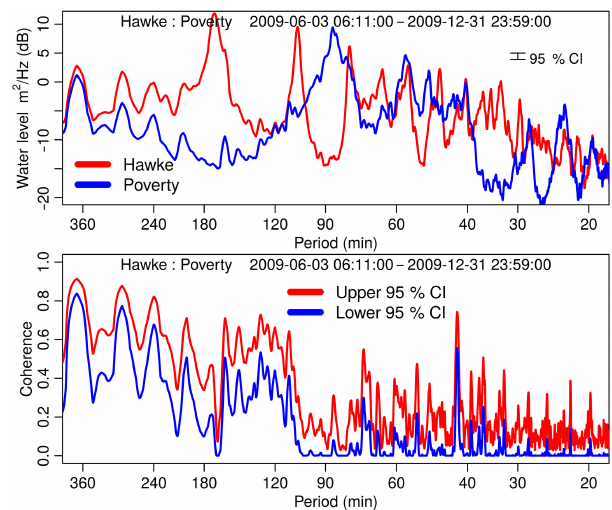
Figure 4. Power spectral density (top) of concurrent water levels at Napier in Hawke Bay, and Gisborne in Poverty Bay. Bottom: coherence of the power spectra shown as the upper and lower 95% confidence interval